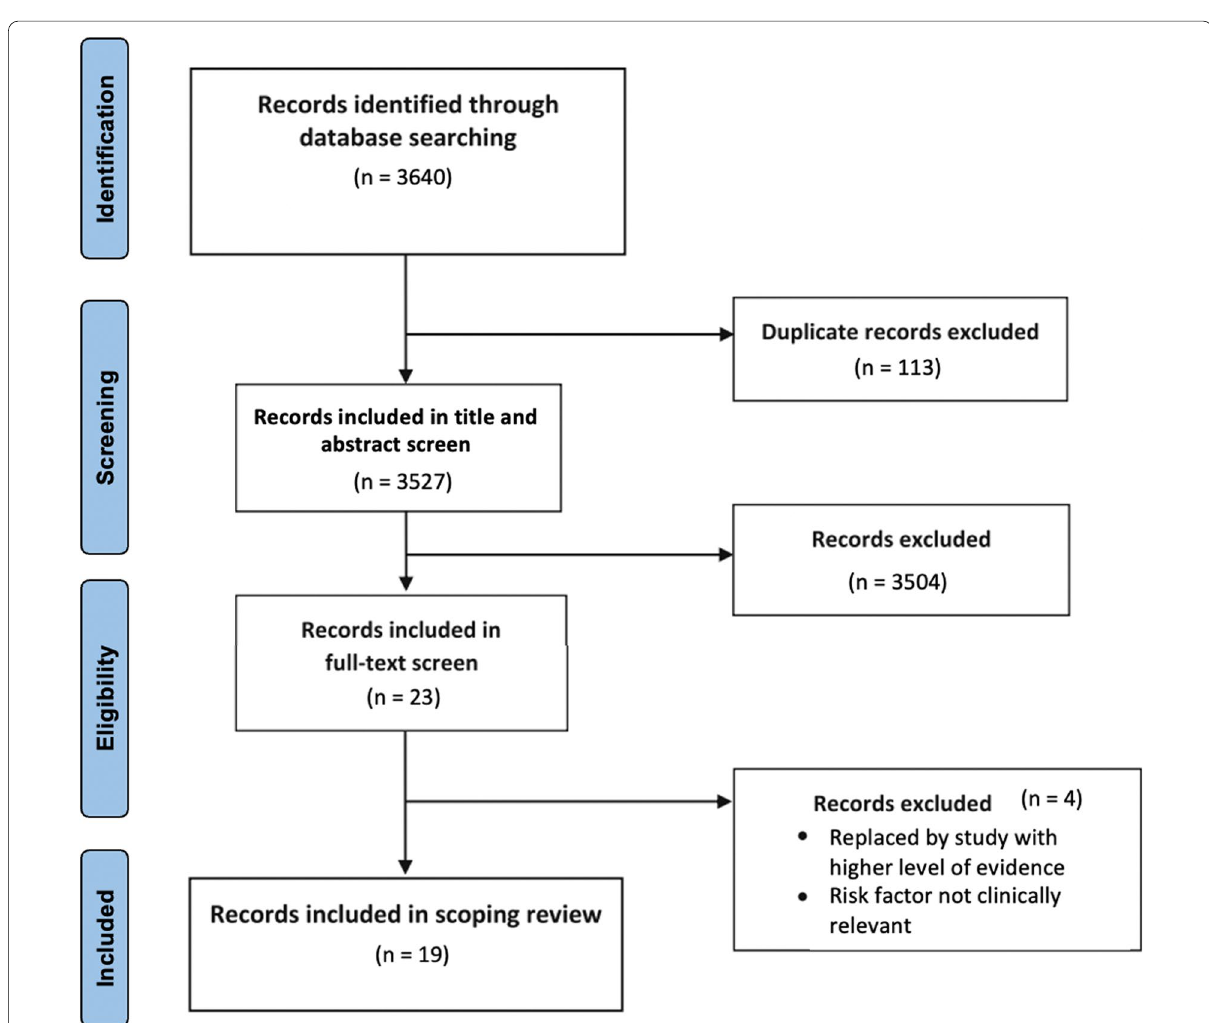
Fig. 1 Flow diagram for a scoping review of maternal risk factors examined to create the Community Maternal Danger